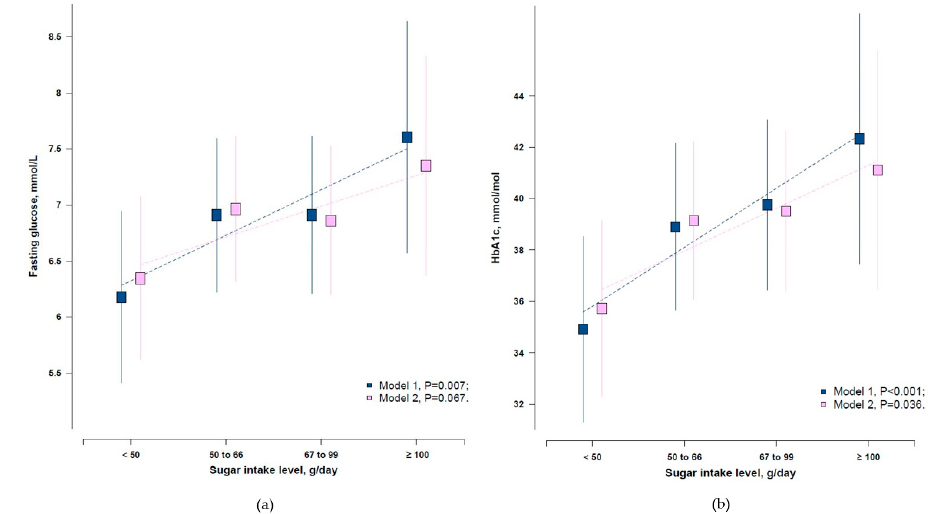
Figure 3. Adjusted means of ( a ) FBG and ( b ) HbA 1c by added sugar intake level among those